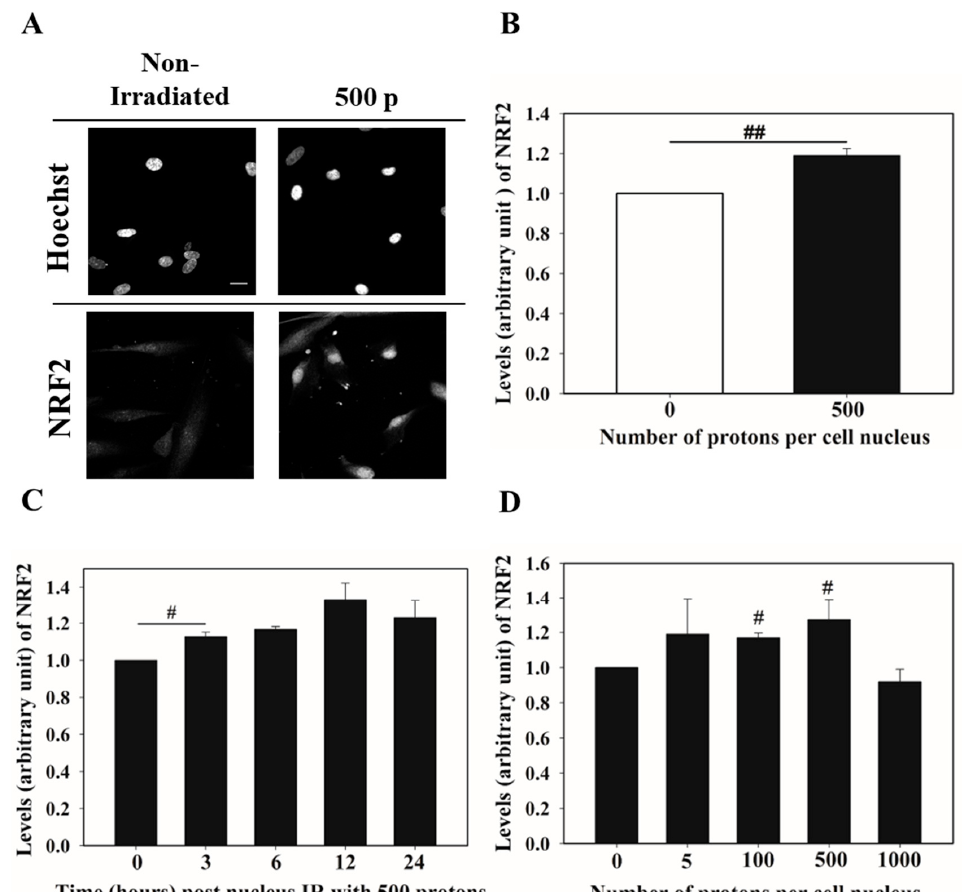
Figure 1. A total of 500 protons were irradiated at the nucleus of WI-38 cells. Twenty-four hours later, immunofluorescence staining revealed the increase in NRF2 in the nuclei. Scale bar = 30 µm ( A , B ). The nucleus of the WI-38 cells was targeted by 500 protons and then incubated. Immunofluorescence staining was used to identify the levels of NRF2 in the nuclei at various time points after irradiation ( C ). The nucleus of the WI-38 cells was targeted by different amounts of protons. Twelve hours later, the nucleus accumulation of NRF2 was detected by immunofluorescence staining ( D ). # P value < 0.05. ## P value < 0.01.